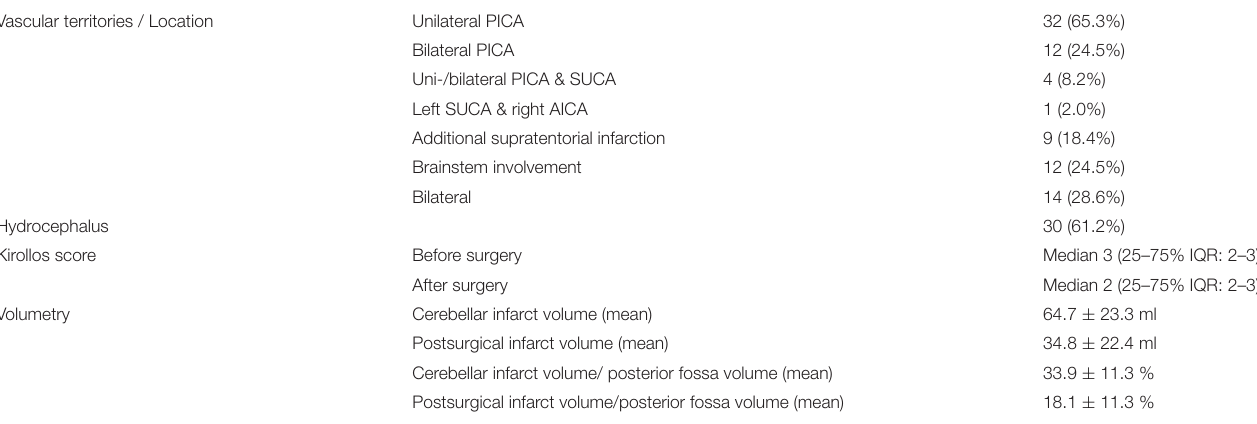
TABLE 2 | Imaging findings. Vascular territories /